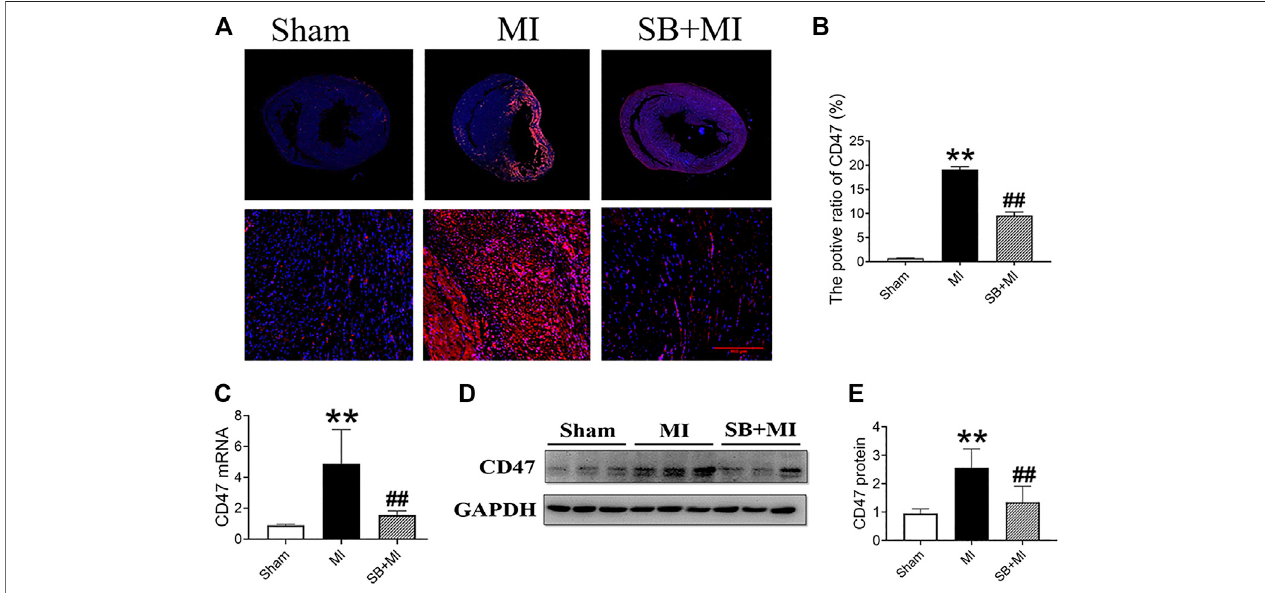
FIGURE 2 | GSK-3 β inhibition decreases CD47 expression in rat MI tissues. (A, B) Representative immuno fl uorescence microscopy image of the heart section at 7 days after MI. Immuno fl uorescence parameter analysis ( n (cid:2) 3/group). (C) Real-time fl uorescence quantitative PCR analysis of CD47 expression in MI tissues of rats at 7 days ( n (cid:2) 7/group). (D, E) Western blot analysis of CD47 expression in MI tissues of rats at 7 days ( n (cid:2) 7/group). Data are presented as the mean ± SD. ** p < 0.01 vs. Sham group; # p < 0.05, ## p < 0.01 vs. MI